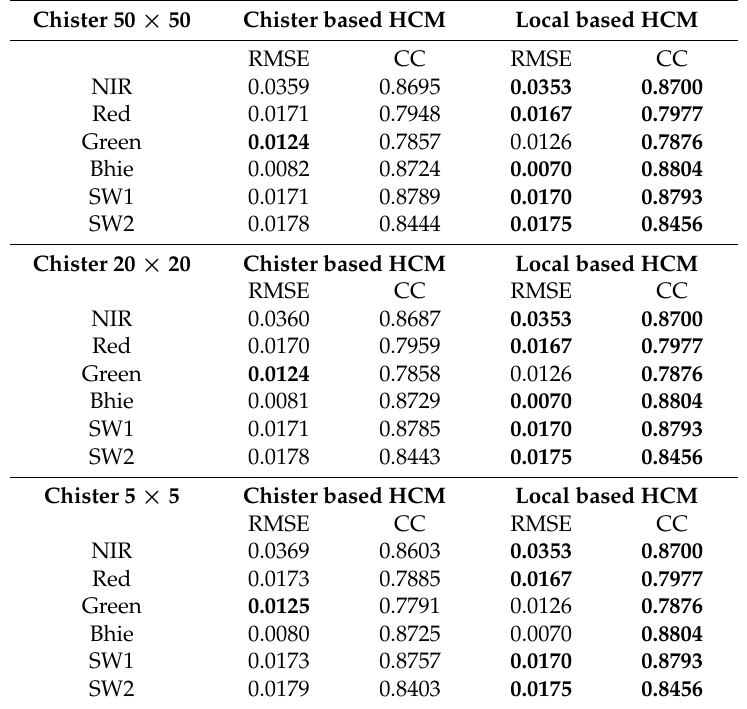
Table 9. Comparison of cluster based HCM with different cluster sizes and local based HCM for heterogeneous areas. Bold numbers indicate high performing